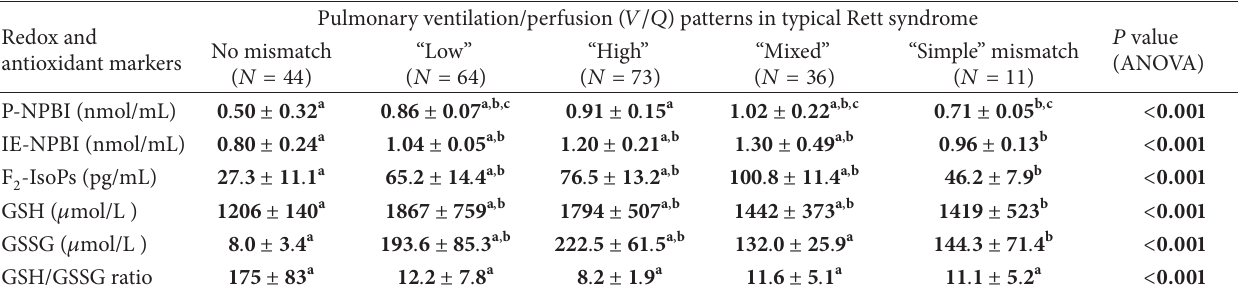
Table 7: Relationships between lung ventilation/perfusion ( 𝑉/𝑄 ) patterns and the redox/antioxidant status in patients with typical Rett syndrome ( 𝑛 = 228